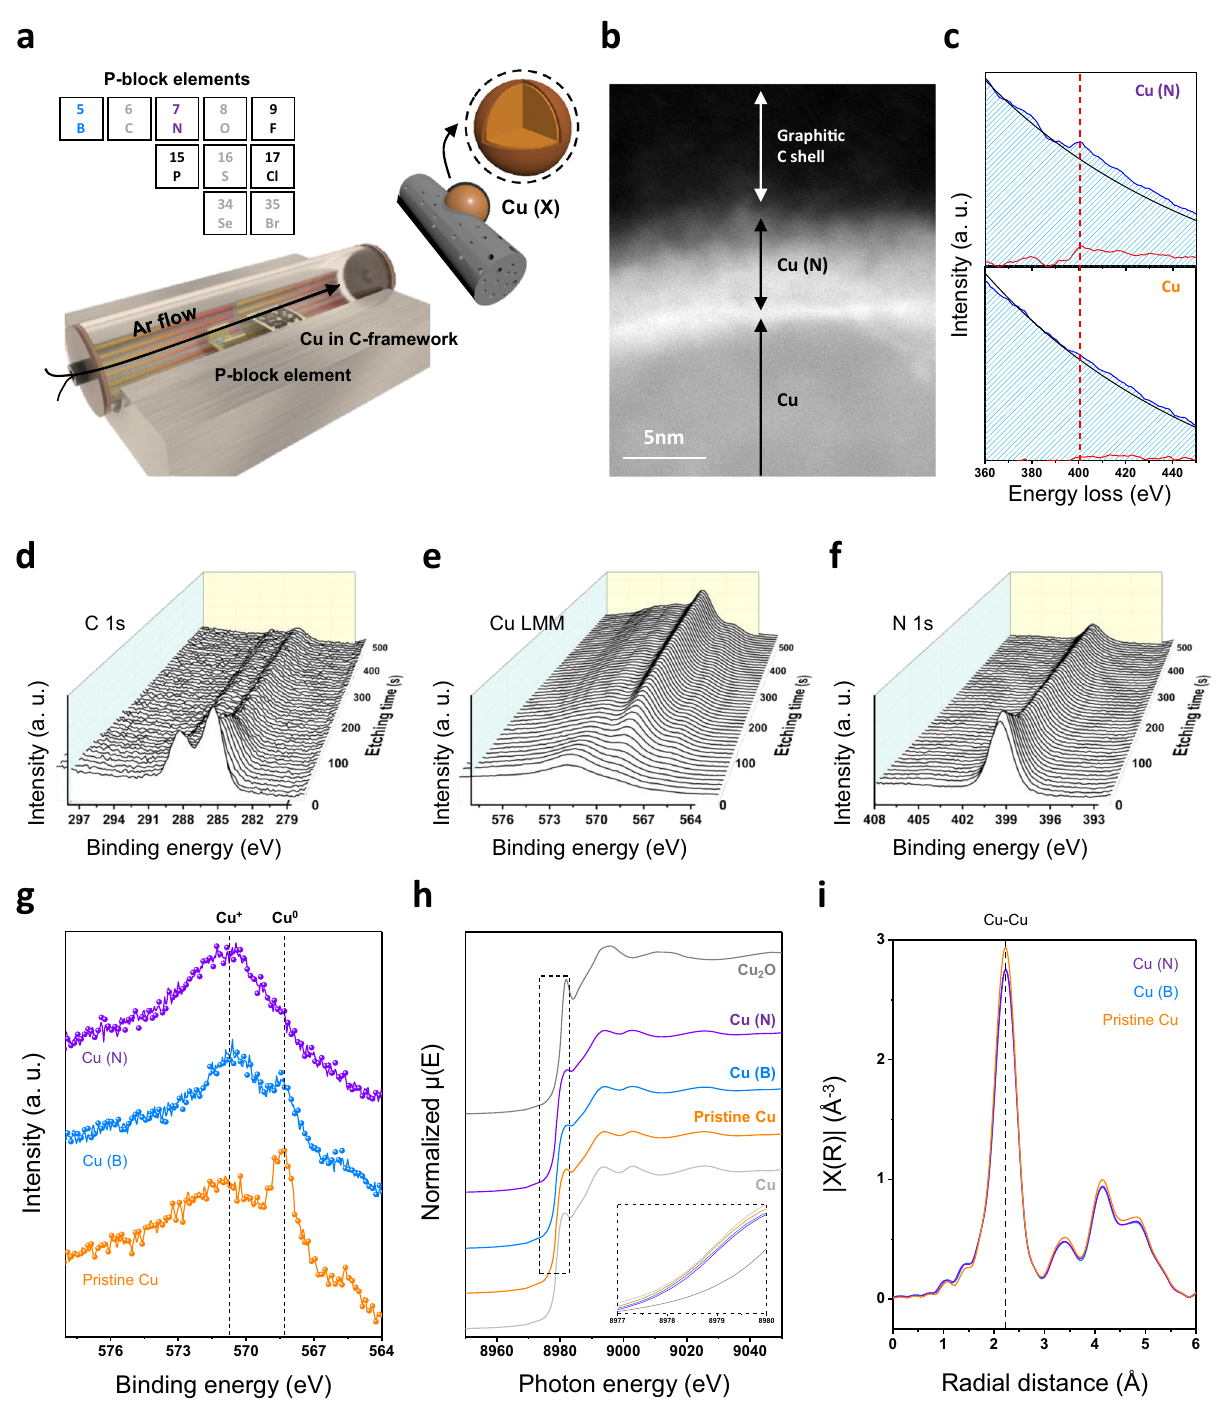
Fig. 3 Preparation and characterization of Cu (X) catalysts. a Schematic illustration of the fabrication of Cu (X) catalysts. b High-resolution TEM image of the Cu (N) fi lm surface. c EELS spectra of Cu (N) and the Cu fi lm. d – f XPS depth pro fi le of the Cu (N) fi lm. Spectra of d C 1s , e Cu LMM , and f N 1s .